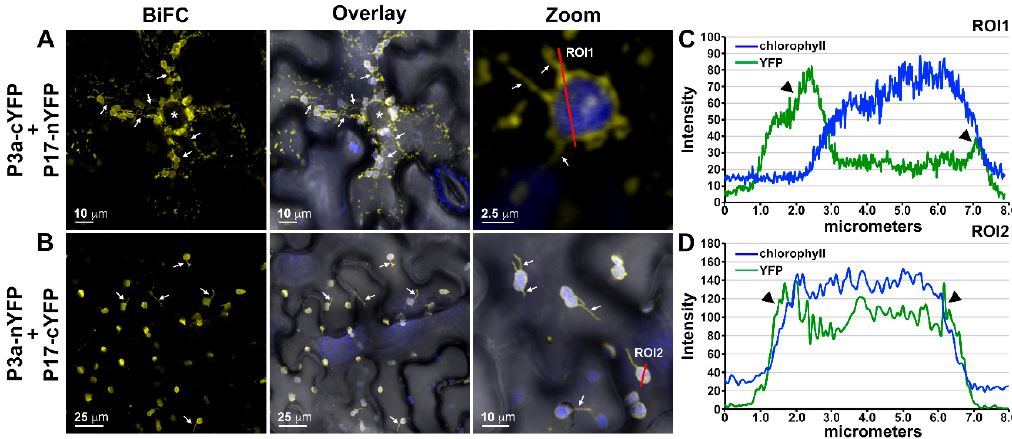
Figure 4. Bimolecular fluorescence complementation (BiFC) assays of PLRV P3a with P17 in leaf epidermal cells show localization of heterodimers to punctate cytoplasmic spots and/or plastids depending on the tag length. ( A , B ) Panels represent single-plane confocal micrographs of cells co-expressing ( A ) P3a-cYFP with P17-nYFP and ( B ) P3a-nYFP with P17-cYFP. Reconstitution of YFP due to the interaction of viral proteins is shown as yellow fluorescence. The overlay of BiFC fluorescence with the brightfield view is shown with chloroplast autofluorescence in blue and co-localization of YFP and chloroplast autofluorescence appearing white. The column marked Zoom is a magnification of a selected region within the overlay image. Scale bars show the length indicated. White arrows and asterisks mark chloroplast stromules and nuclei, respectively. ( C , D ) Line graphs show the fluorescence intensities of YFP and chlorophyll measured every ( C ) 0.015 and ( D ) 0.072 micrometers across the region of interest (ROI) highlighted by the red line in the Zoom micrographs of panels A and B, respectively. Black arrowheads indicate a region where YFP fluorescence is increased at the edge of the plastid body where chloroplast autofluorescence is in decline.